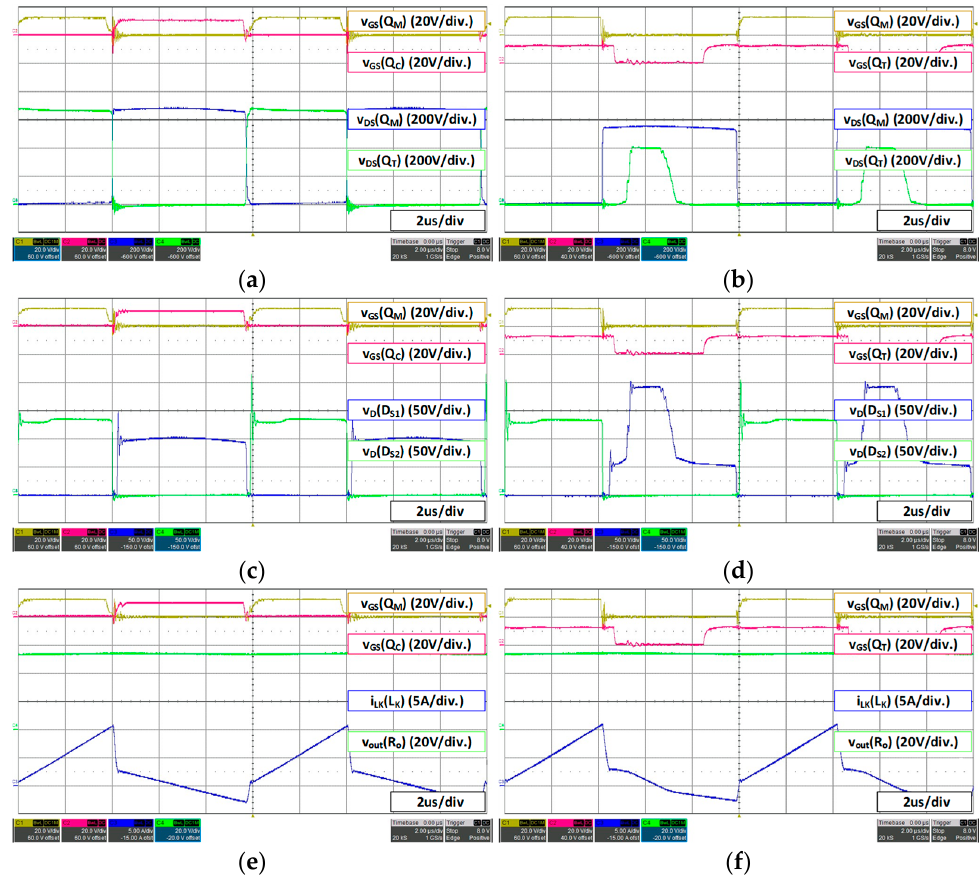
Figure 14. 48 V battery (53.3 V 15 A) load waveform: ( a ) conventional converter MOSFET voltage stress; ( b ) proposed converter MOSFET voltage stress; ( c ) conventional converter secondary rectifier voltage stress; ( d ) proposed converter secondary rectifier voltage stress; ( e ) conventional converter V out ; ( f ) proposed converter V out .